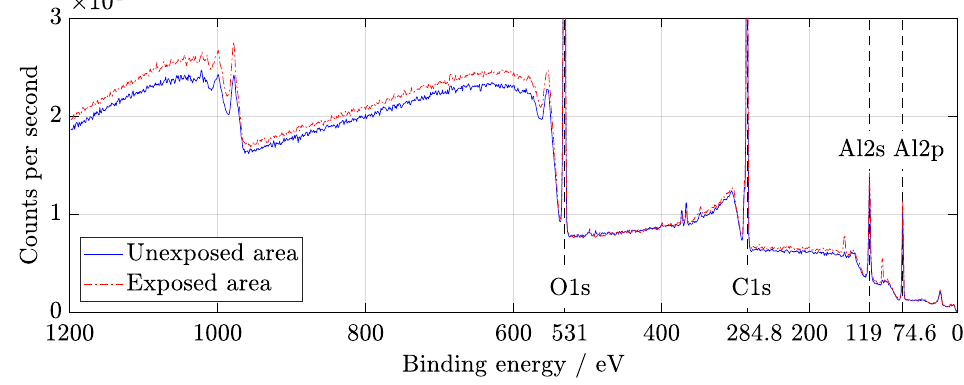
Figure 5. Wide X-ray Photoelectron Spectroscopy (XPS) spectra of exposed and unexposed area from supercontinuum laser irradiation. Four significant peaks are marked: O1s, C1s, Al2p, and Al2s. These regions were then examined in high resolution. Al2p and Al2s peaks are associated with thin anti-reflection layers.